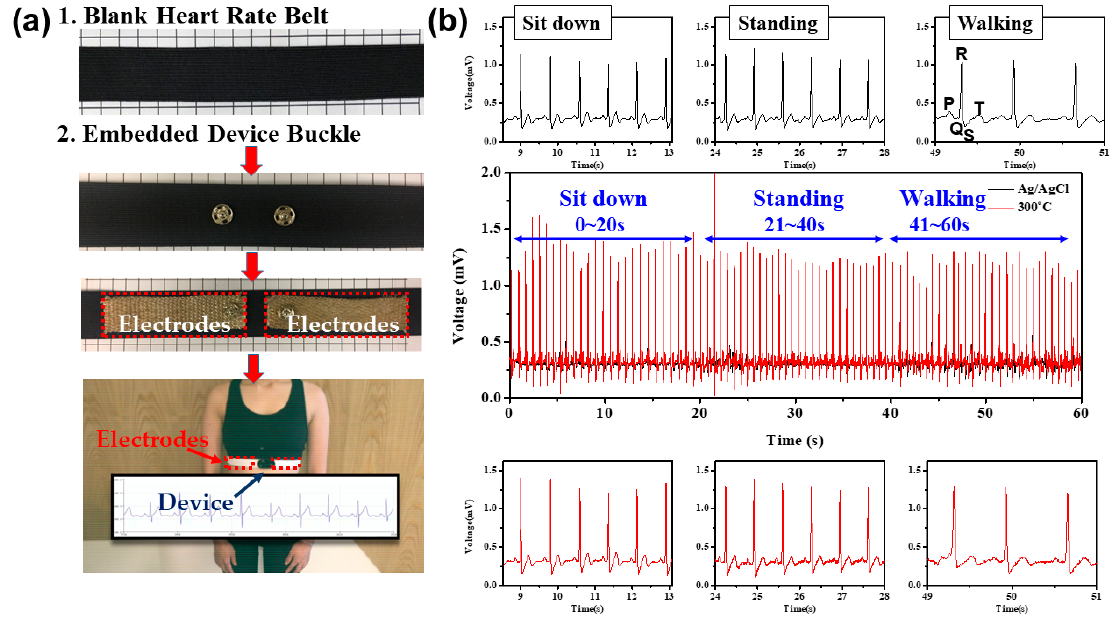
Figure 5. ( a ) Optical images of heart rate monitor device featuring silver-based electrodes. ( b ) Magnified view of the measured electrocardiogram (ECG) wave, showing the P-wave, QRS-complex, and T-wave under different